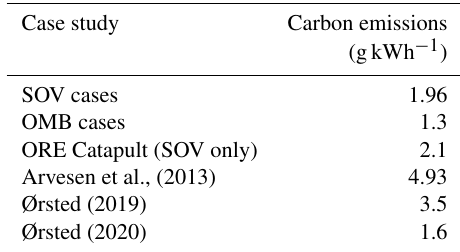
OMB case there would be an additional cost of helicopter or vessel delivery of a part if it is not available at the site. Table 7. Benchmarking results from simulations with other studies (Gray,